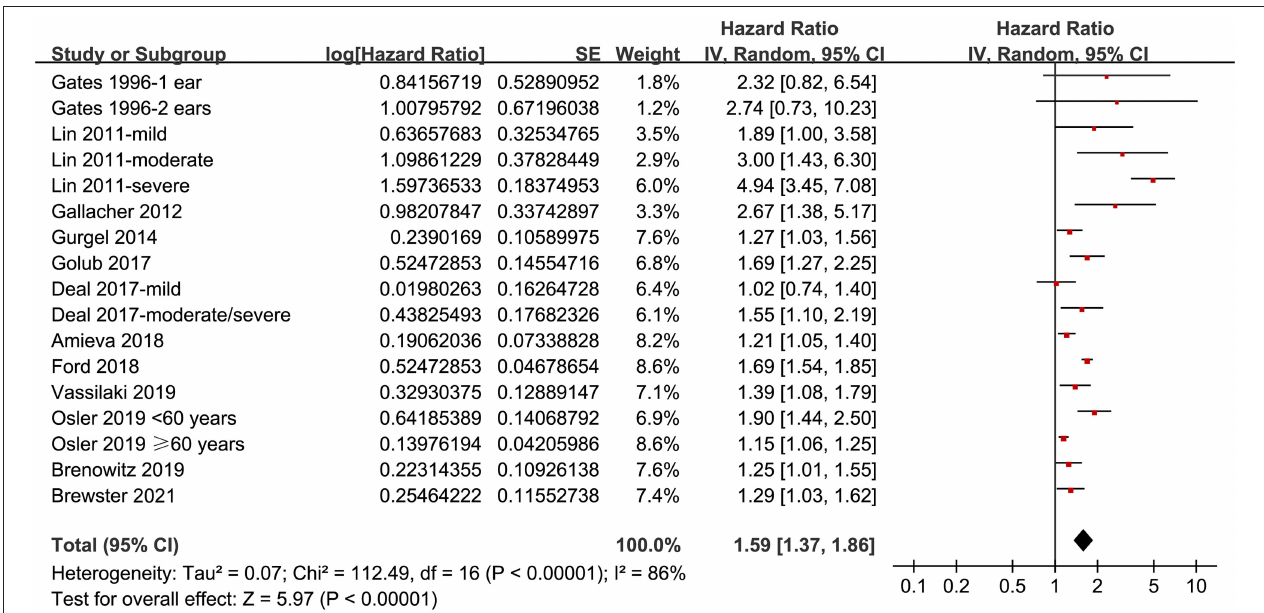
FIGURE 2 | Forest plots for the meta-analysis concerning the association between hearing loss and the subsequent incidence of all-cause dementia.